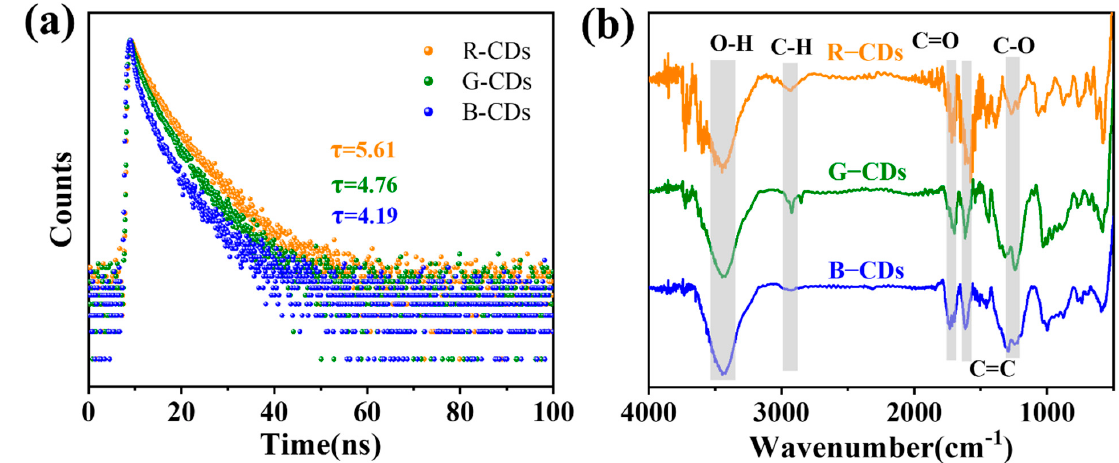
Figure 4. ( a ) Photoluminescent decays. ( b ) FT–IR spectra of R-CDs to B-CDs in ethanol.